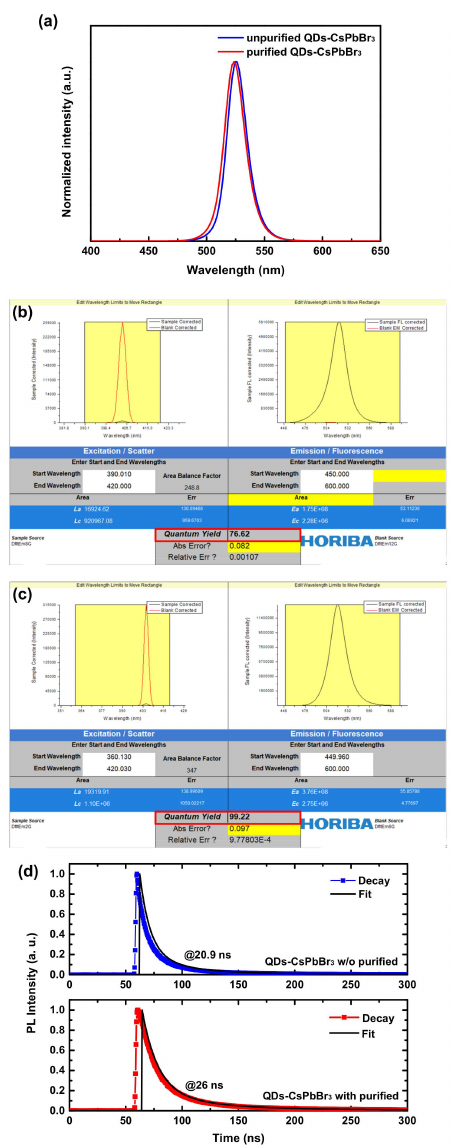
Figure 8. ( a ) Normalized PL emission spectra of unpurified and purified QDs-CsPbBr 3 solutions; ( b ) and ( c ) photoluminescence quantum yield (PLQYs) of unpurified and purified QDs-CsPbBr 3 solutions; ( d ) Time-Resolved Photoluminescence (TRPL) decay profiles of unpurified and purified QDs-CsPbBr 3